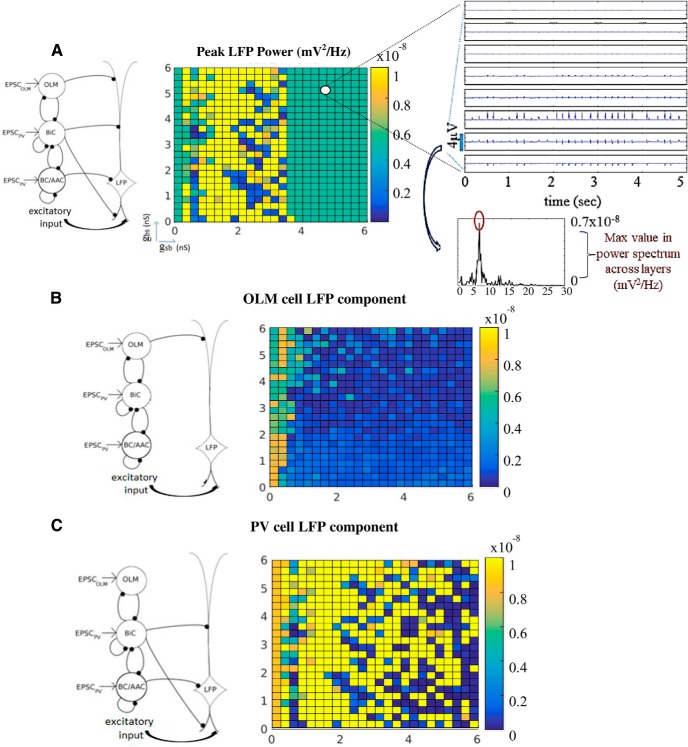
Decomposition of the LFP signal. A, All presynaptic cell populations are present. B, Only OLM cells are present. C, Only BiCs and BC/AACs are present. Schematics on the left show the cell populations projecting to the PYR cell. Computations are done across gsb and gbs parameter values where csb =0.21. For each parameter set, LFPs are computed across all layers and the power spectrum is computed for each layer. The maximum power across all layers is taken as the peak power and given in the color plot. Computation is illustrated to the right of A (see text for details).